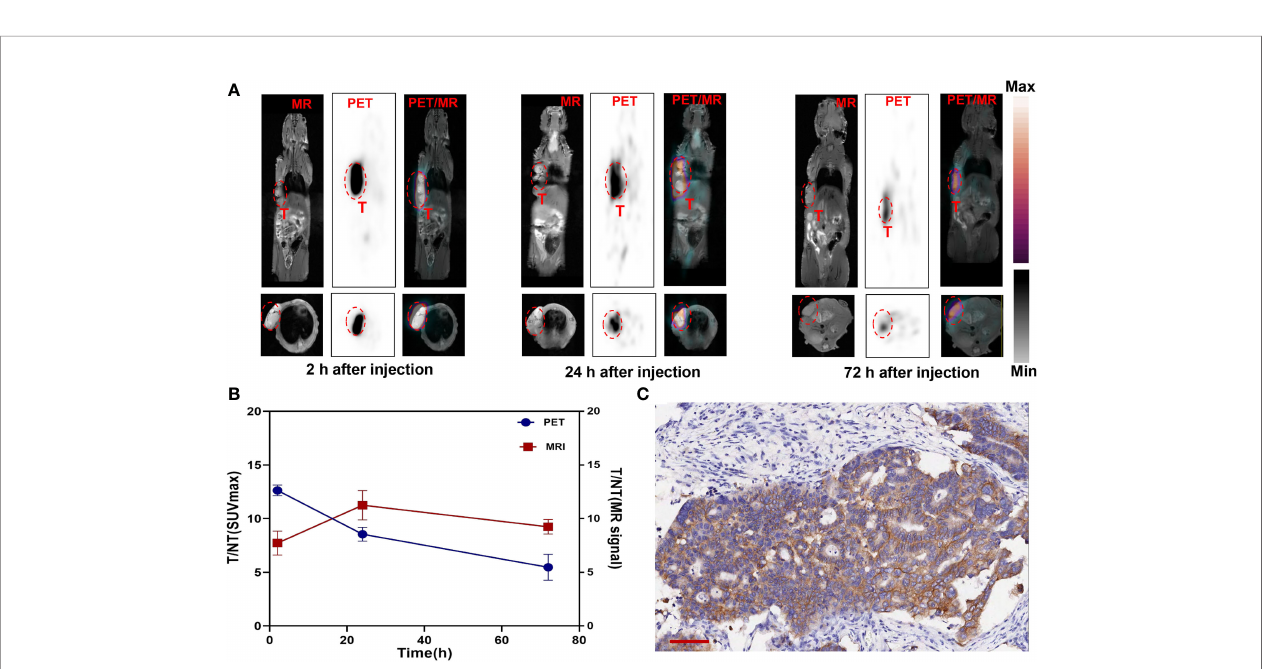
FIGURE 4 | (A) T1-weighted MR axial images of gastric cancer PDX model at 2, 24, and 72 h post-injection Mn-Her-PEG-dMNPs (tumor site enveloped by a red dotted line). (B) The radioactivity distribution of PET/MRI assessed by the T/NT ratios of SUVmax and MR signal changed over time at the tumor site as determined using the ROI. (C) Immunohistochemical staining for gastric cancer PDX model tumor tissues. Scale bar = 100 µm.